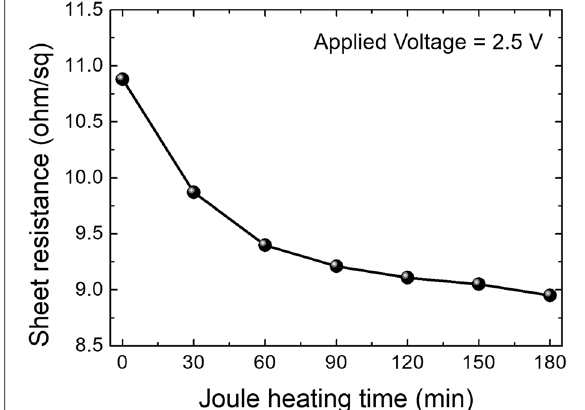
Fig. 6 Change in the sheet resistance of the Cu mesh/PVA film with respect to the thermal treatment time by Joule